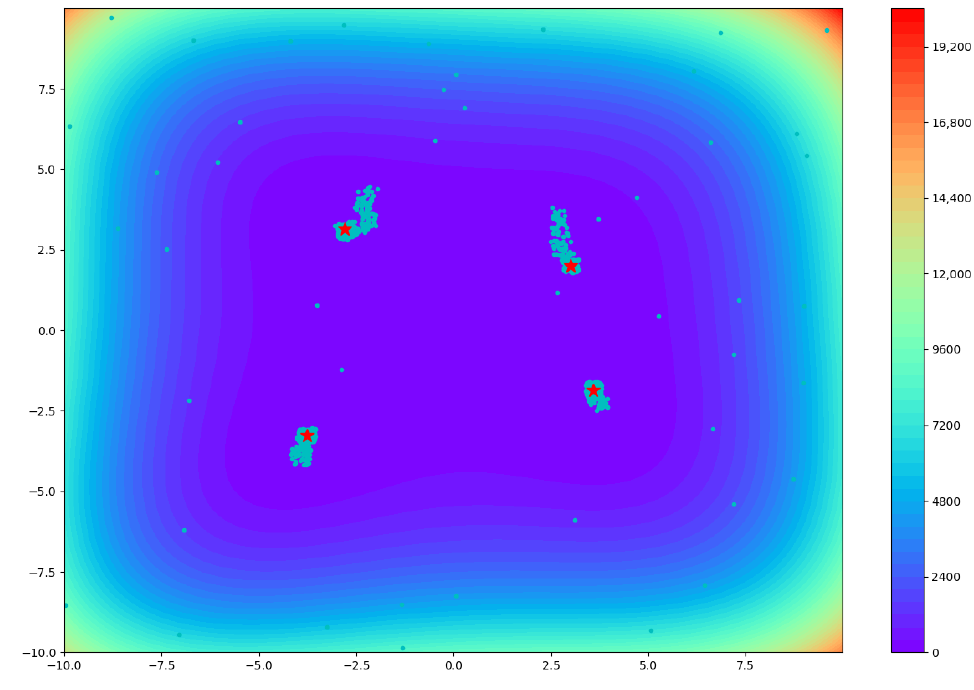
Figure 6. Himmelblau function.